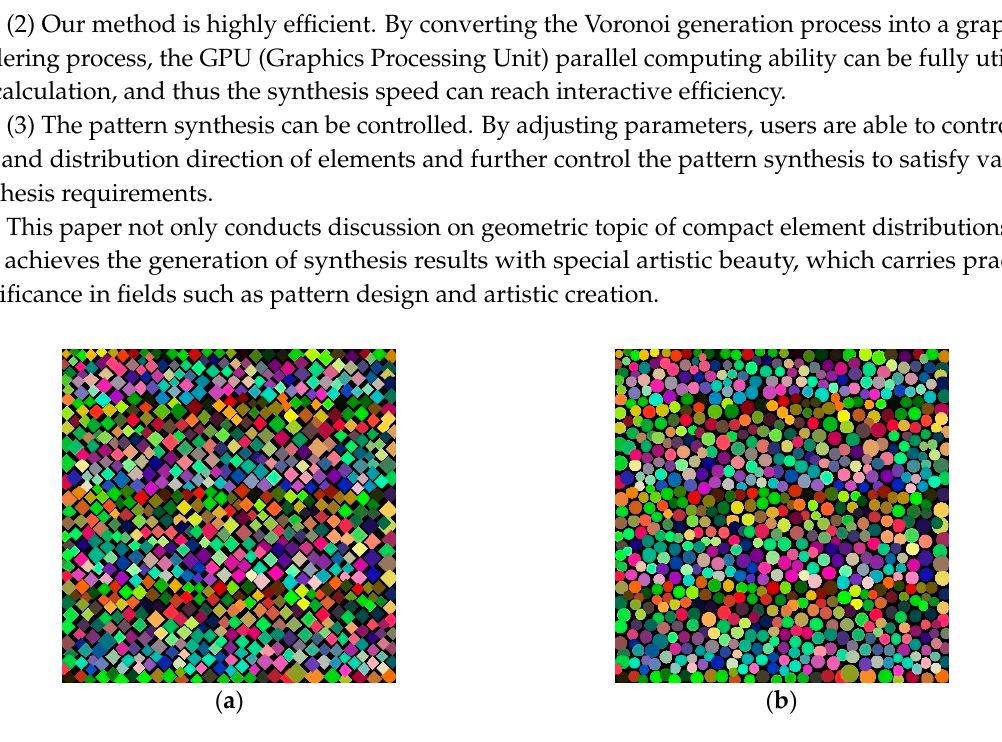
Figure 1. Synthesis effect of the work in this paper: ( a ) square elements; ( b ) circular elements.